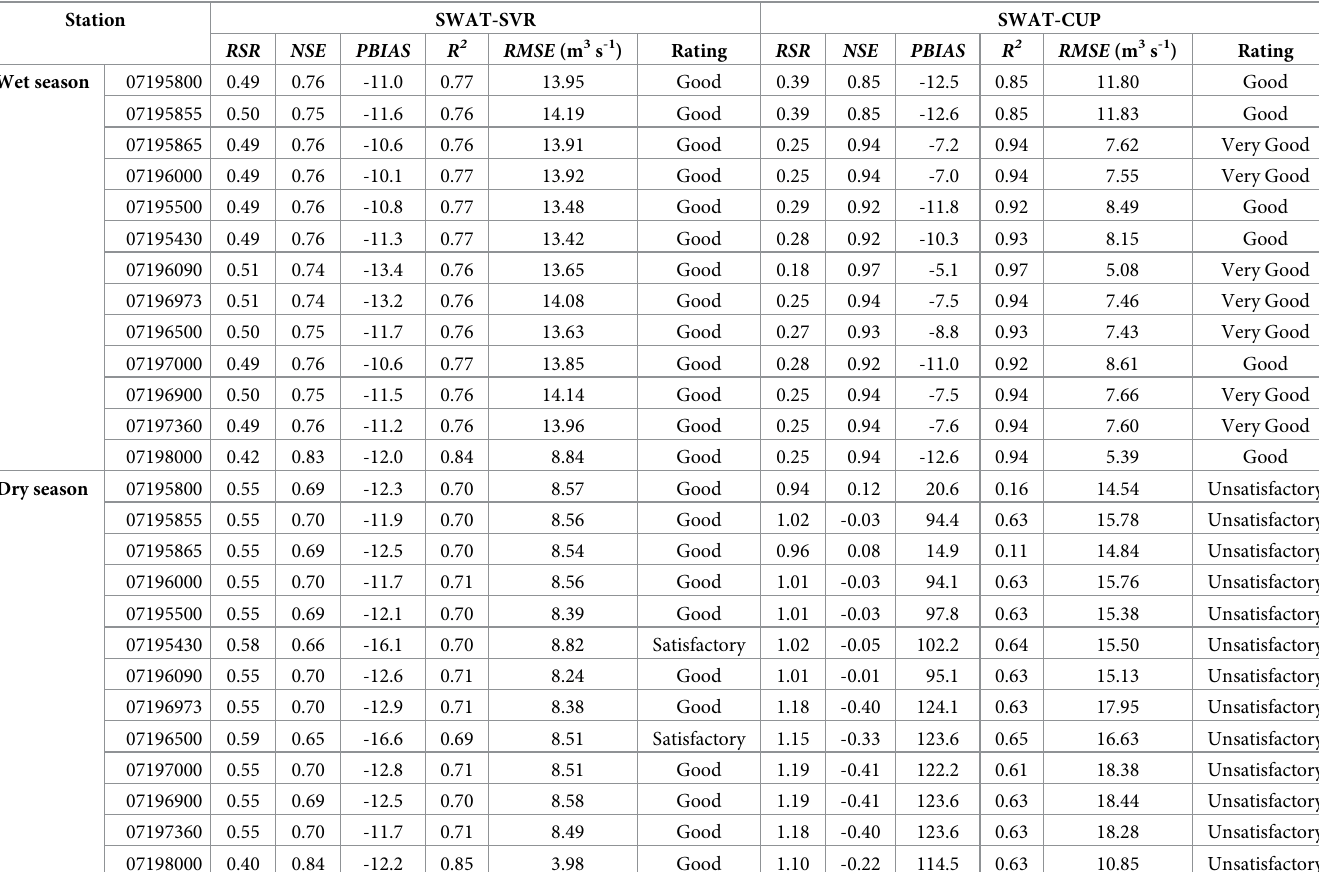
Table 4. Calibration performance of streamflow simulations by SWAT-SVR and SWAT-CUP during the wet and dry seasons.